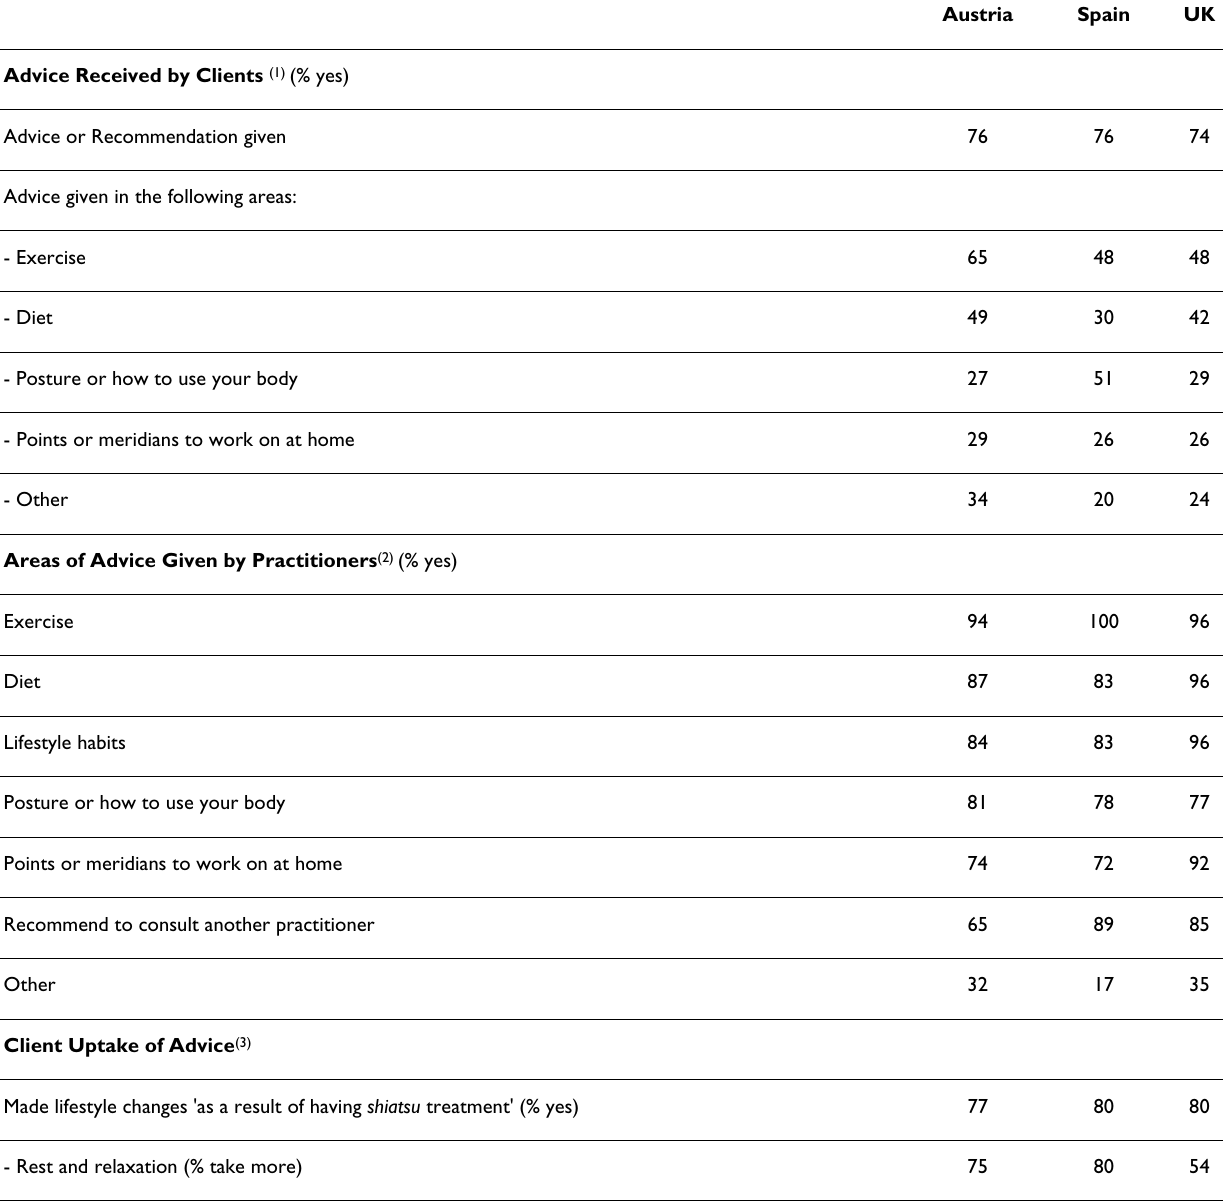
Table 1: Areas of Advice Received and Given and Their Update